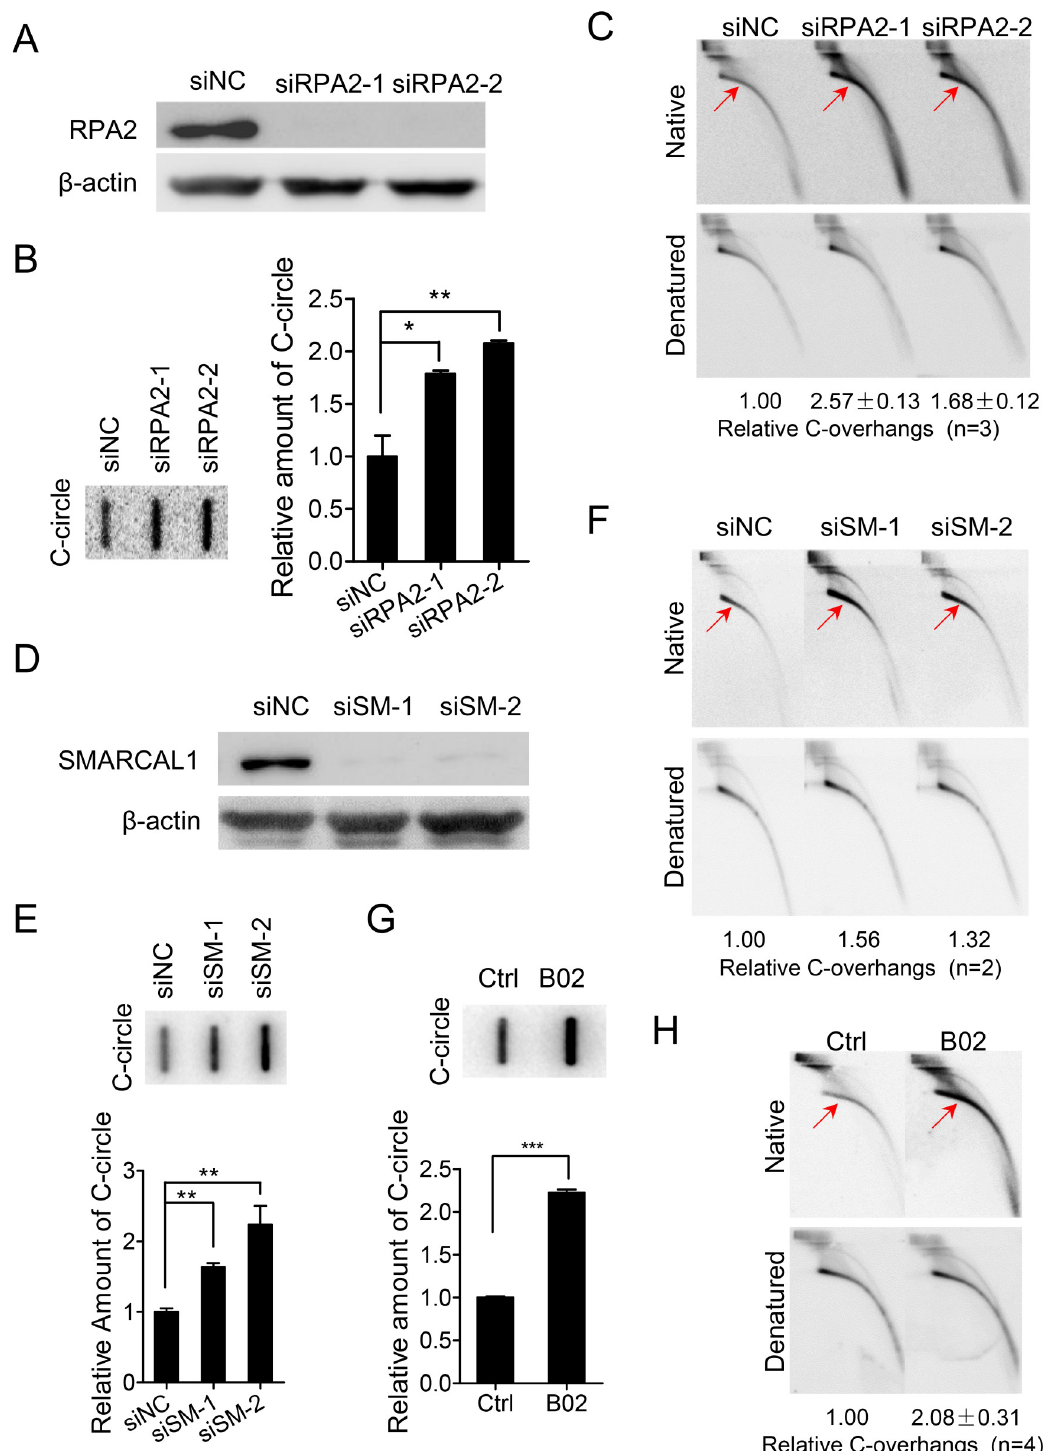
Fig 5. Defect in replication fork regression increases abundance of C-circles and 5’ C-overhangs. (A) Western blot shows efficiency of RPA2 knockdown by siRNA. β -actin was used as a loading control. U2OS cells were collected 60h after transfection with siRNA. (B) Abundance of C-circles in RPA2-depleted cells. Error bars represent the mean ± SEM of three independent experiments. Two-tailed unpaired student’s t -test was used to calculate P-values. � P < 0.05, �� P < 0.01. (C) Abundance of 5’ C- overhangs in RPA2-depleted cells. C-overhangs abundance was expressed as a ratio between the native and denatured